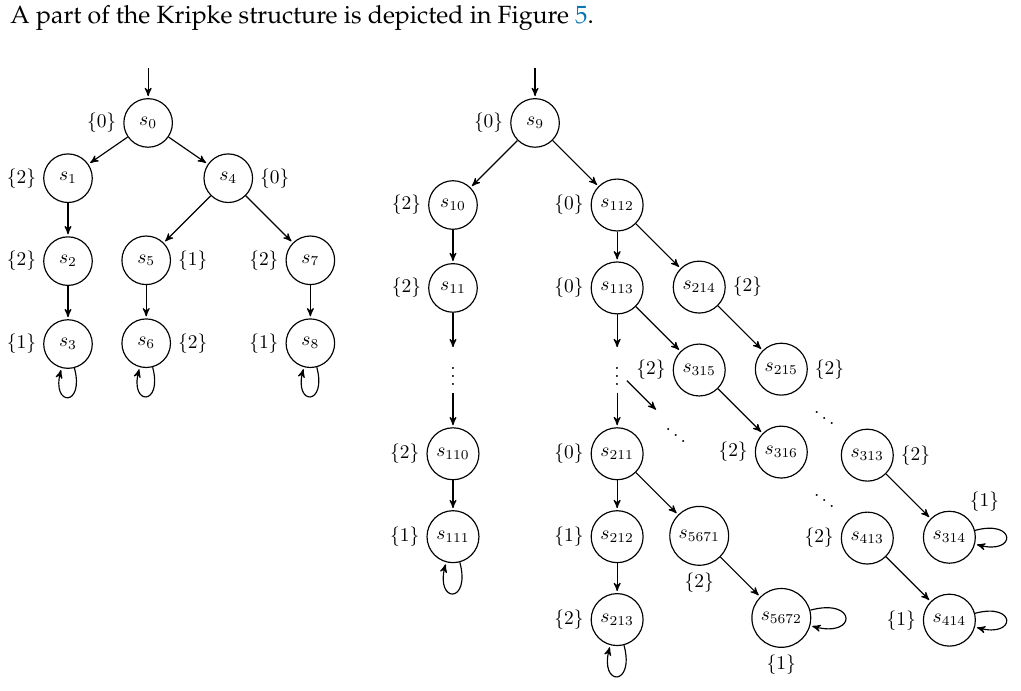
Figure 5. Kripke structure of the program P6